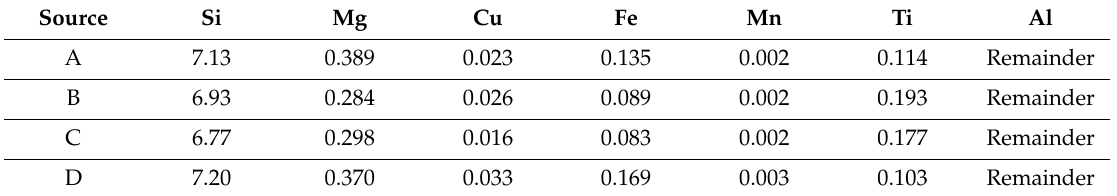
Table 1. Chemical analysis of the A356 aluminium ingots used in the